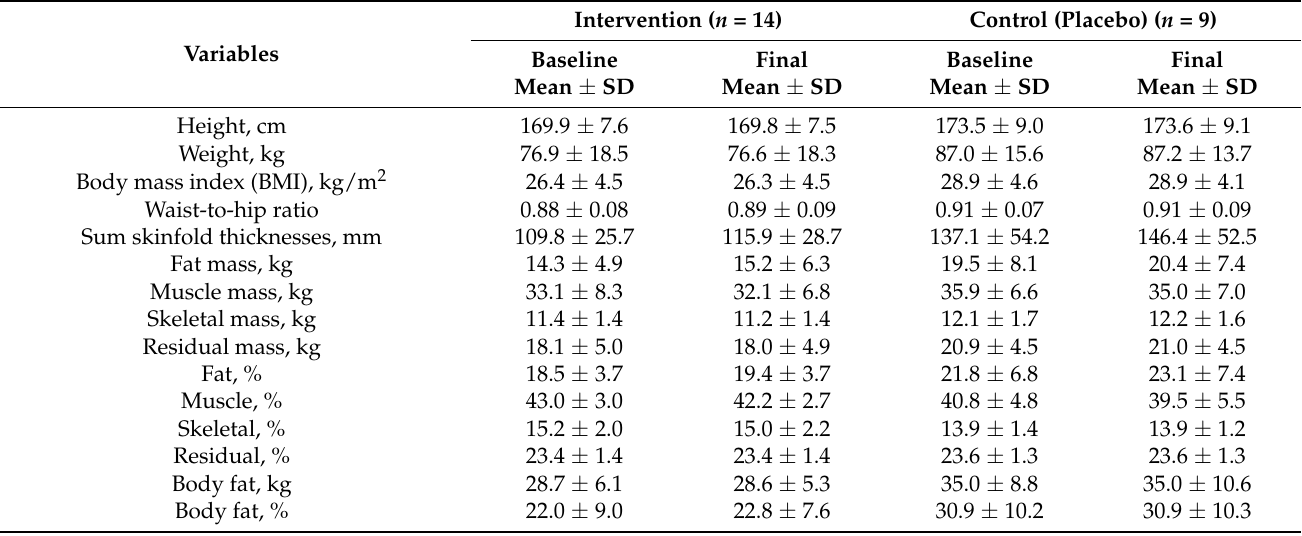
Table 2. Changes of anthropometric variables during the study